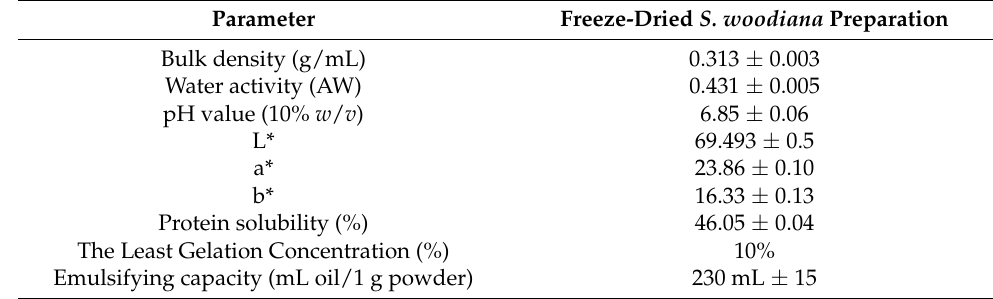
Table 5. Physical and physico-chemical characterization of the dried soft tissue of S. woodiana